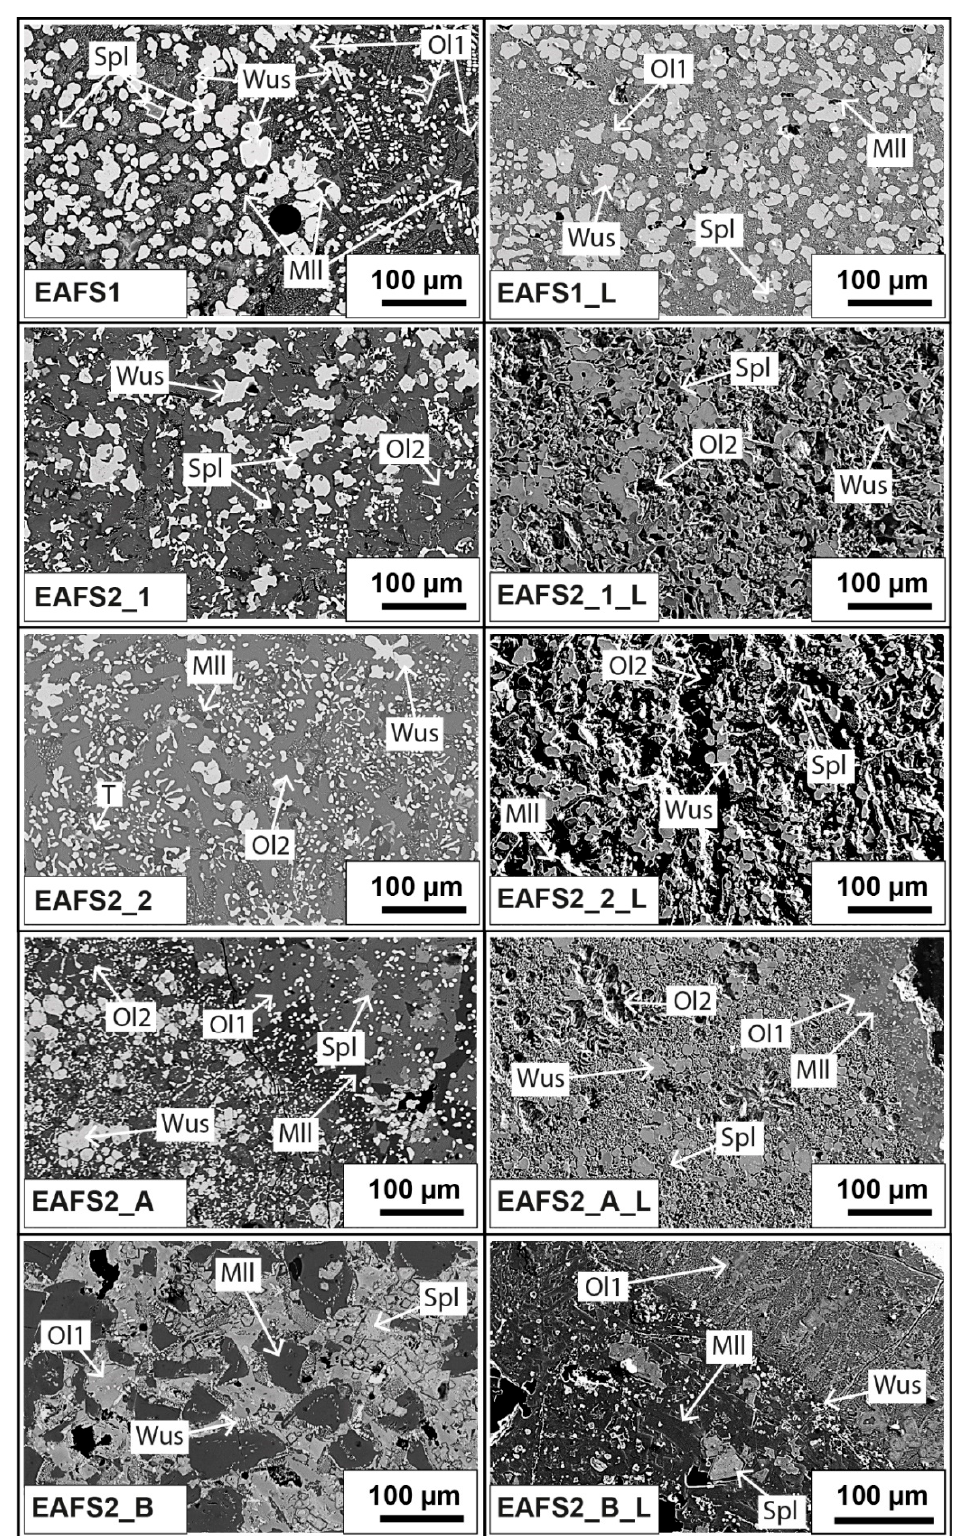
Figure 1. Electron images of five EAF slag samples taken by EMP. ( Left ) Backscattered electron (BSE) images before leaching. ( Right ) Secondary electron (SE) images after leaching. Abbreviations: wuestite (Wus), spinel (Spl), olivine (Ol), melilite (Mll), and Ca-Ti-phase (T).